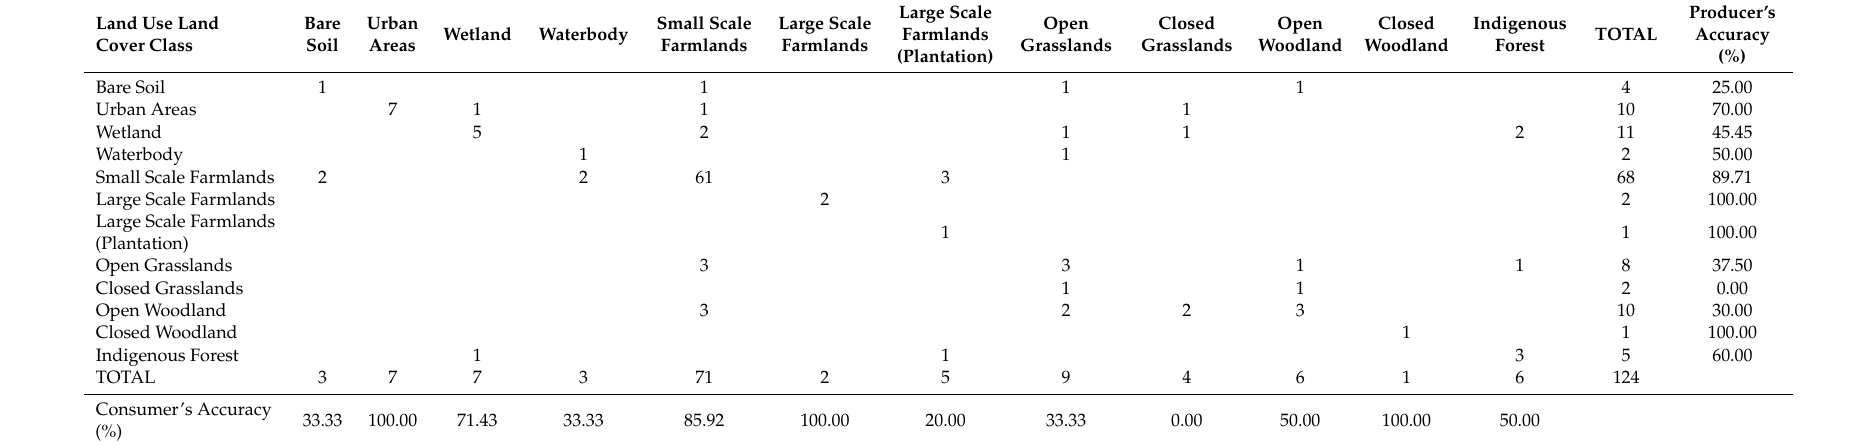
Table 1. Confusion matrix between interpreted and validation results for